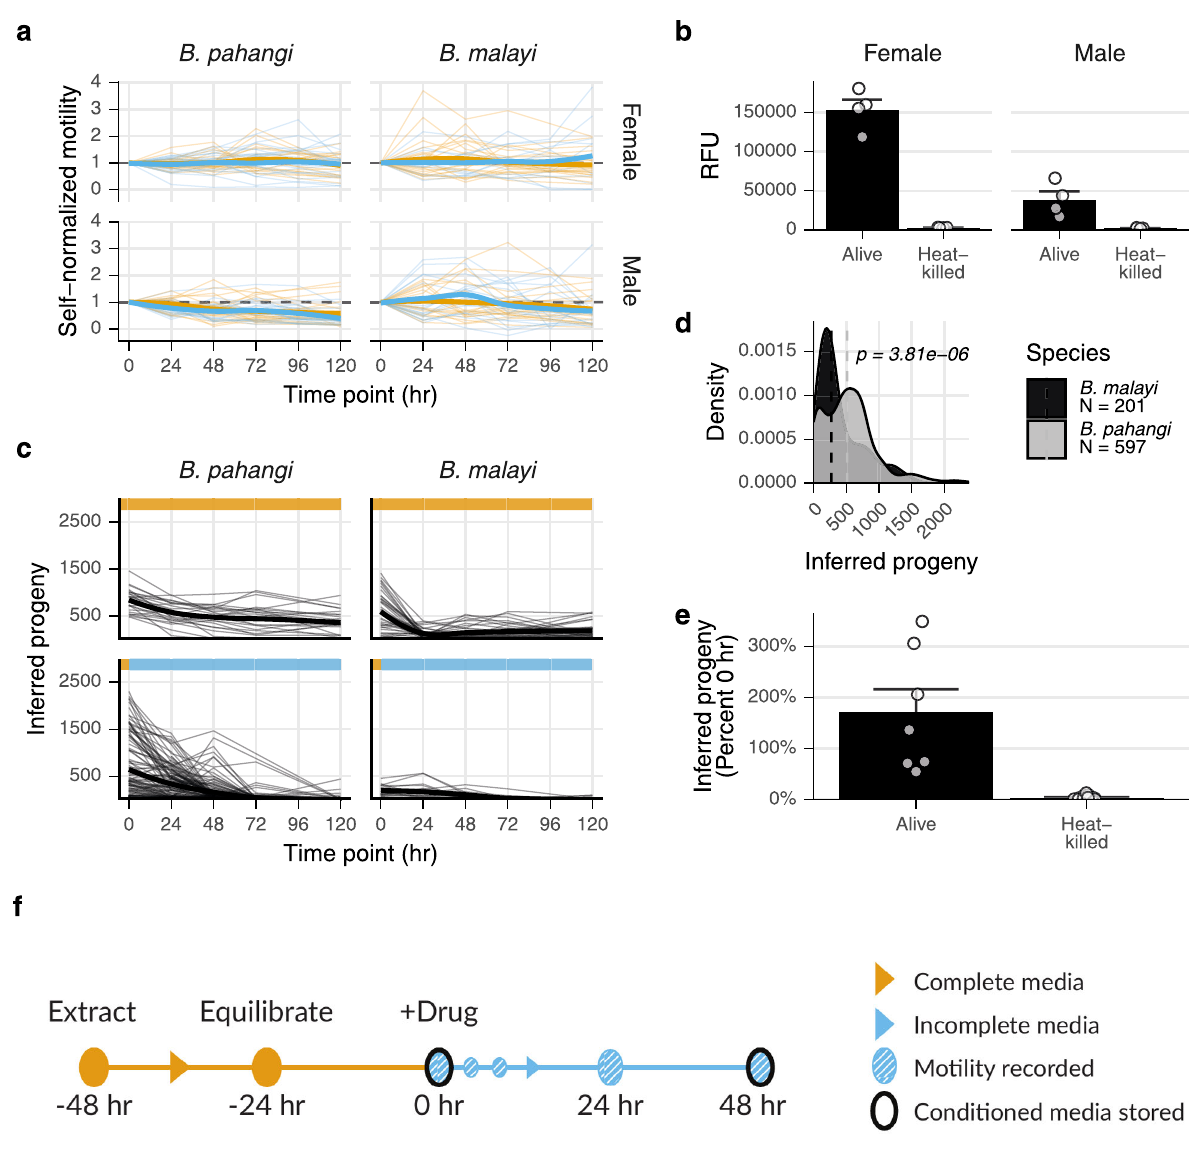
Fig. 5 Optimization of multivariate Brugia spp. adult screen. a Motility of B. pahangi and B. malayi adult males and females over 120 h in culture in media with (complete, orange) or without (incomplete, blue) serum. b Lactate production of B. pahangi adult males and females after 48 h in incomplete media. c Progeny released every 24 h over 120 h in culture in complete or incomplete media. d Progeny released after overnight culture in complete media. p value calculated with Kruskal – Wallis test. e Progeny released after 48 h. f Final optimized screening strategy incorporating four total phenotypes. Error bars represent the standard error of the